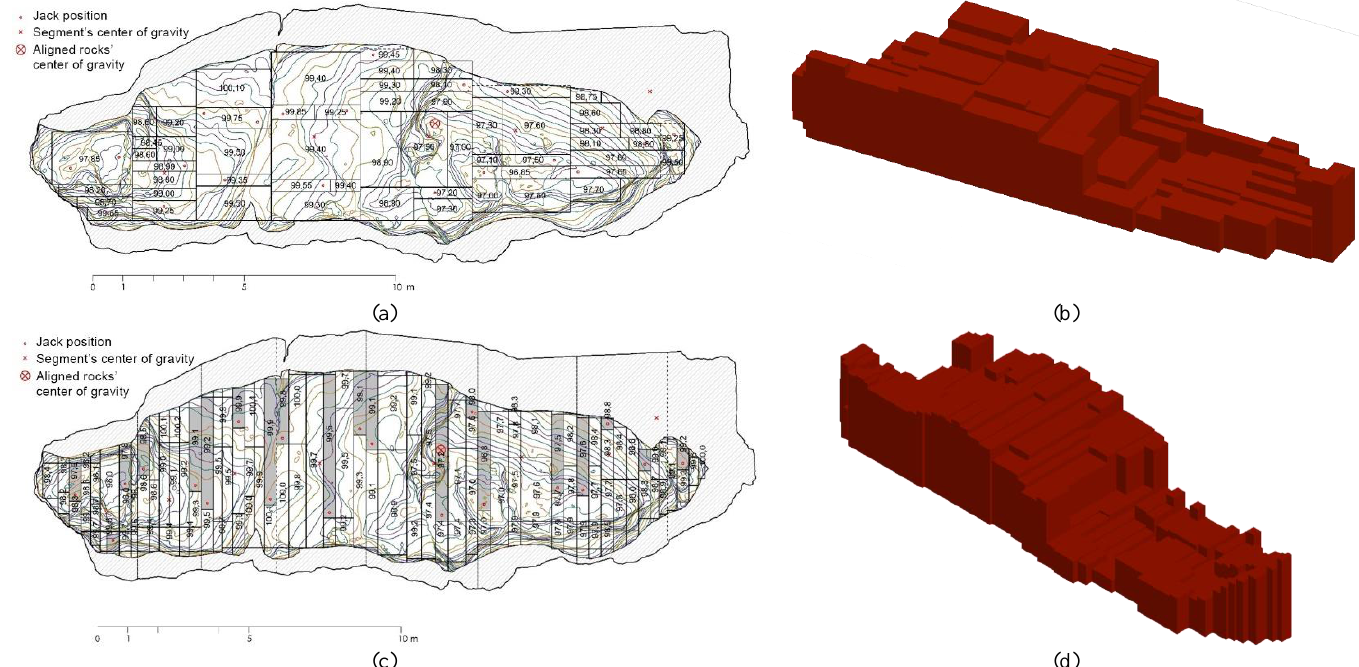
Figure 12: The upper surface of the substructure. (a) Bottom view of the aligned rocks 1A, 1B & 1C along with the design of the substructure for the ejection of the lifting jack from the long sides of the rock segments, (b) perspective view of the upper side of the substructure designed for the ejection of the lifting jack from the long sides of the rock segments, (c) Bottom view of the aligned rocks 1A, 1B & 1C along with the design of the substructure for the ejection of the lifting jack from the short sides of the rock segments, (d) perspective view of the upper side of the substructure designed for the ejection of the lifting jack from the short sides of the rock